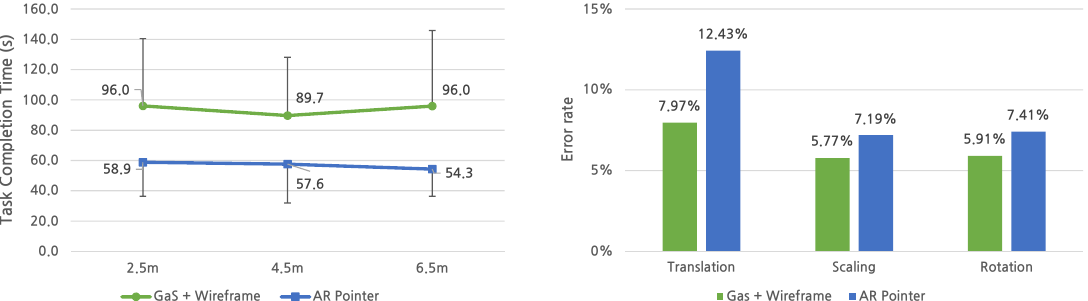
Figure 7. Result of experiment 2. ( left ) task completion time. ( right ) error rate.